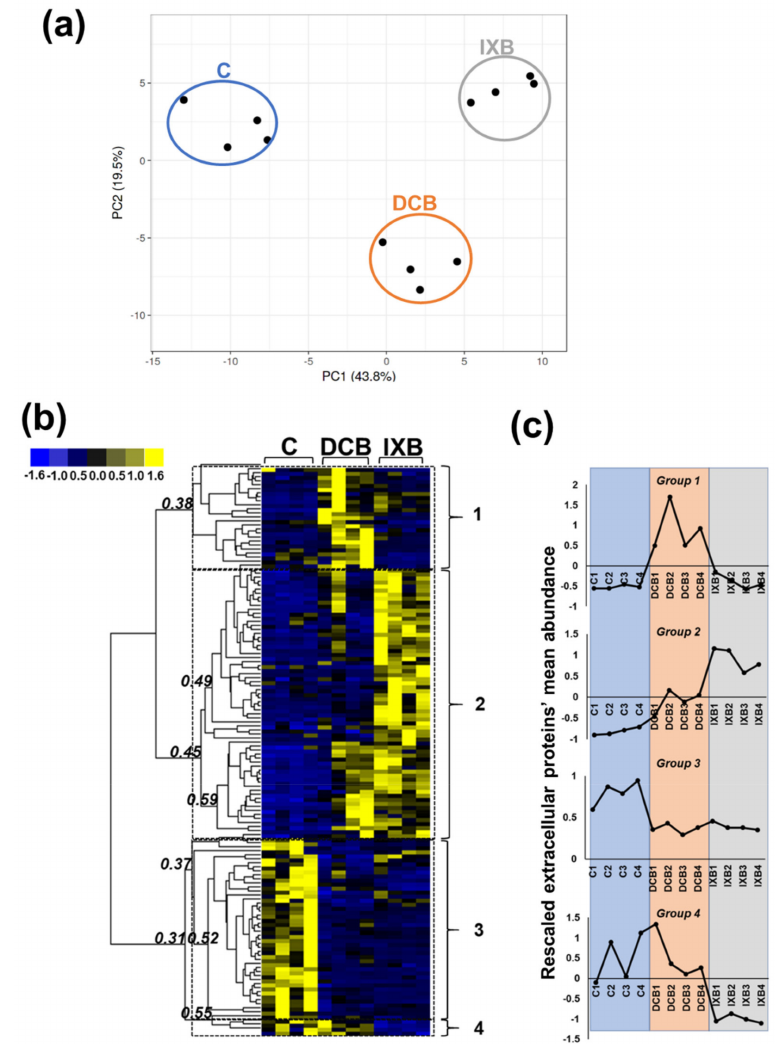
Figure 5. Principal Component Analysis (PCA) in ( a ) of the normalized abundances of extracellular proteins passing the selection filters ( p -value < 0.05, max FC > 1.5) identified using a gel-free approach in the three fractions. Heatmap hierarchical clustering (HC) in ( b ) of the data used in ( a ) after unit variance scaling [43]. Unit variance scaling was calculated by subtracting from each value the average among all the conditions and dividing by the standard deviation. The numbers in italics in ( b ) indicate the Pearson’s coefficients. The graphs in ( c ) indicate the profiles of the 4 groups determined by setting a correlation coefficient threshold